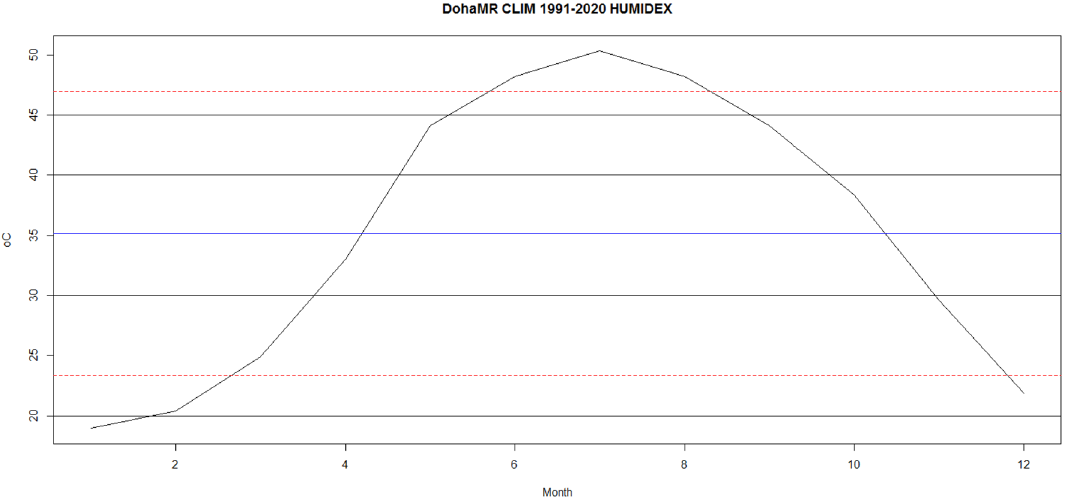
Figure 4 evidences the Thermal Discomfort Index (TDI) for the Doha metropolitan area throughout the